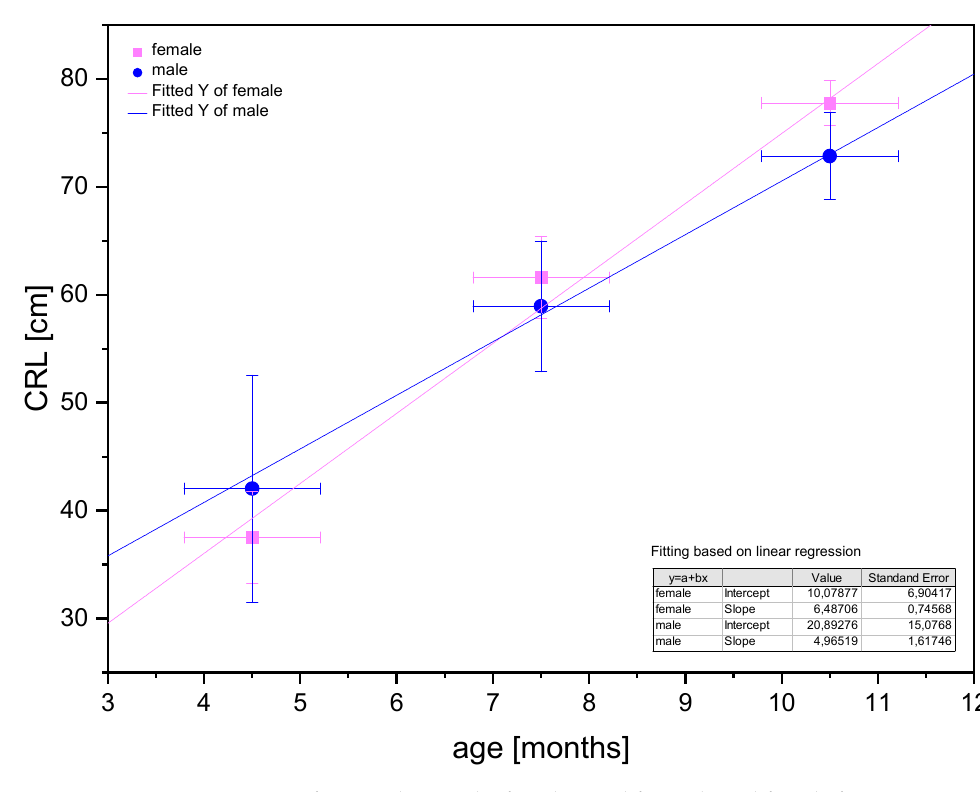
Figure 13. Linear regression of CRL values in the foetal period for male and female foetuses proving the isometric growth of the CRL (after Poradowski and Chrószcz [15]).